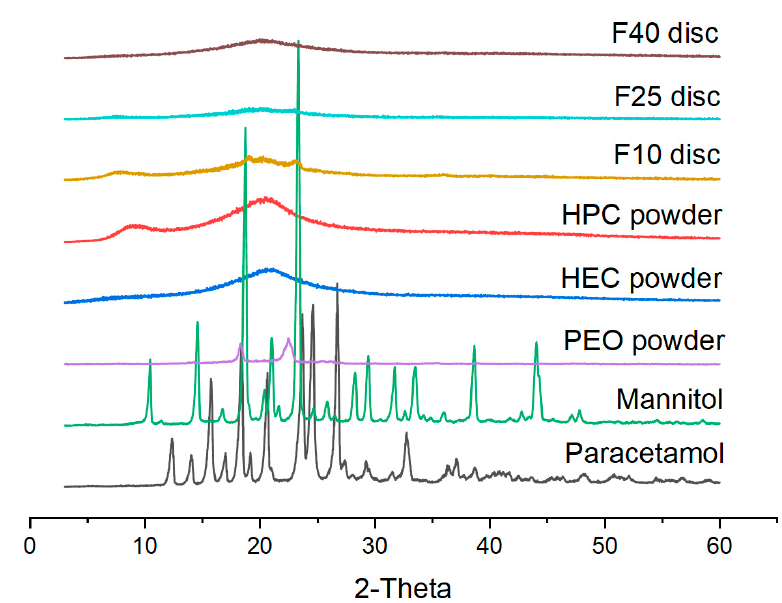
Figure 5. XRPD diffraction pattern of the printed formulations discs, the powdered polymers, and the drug.